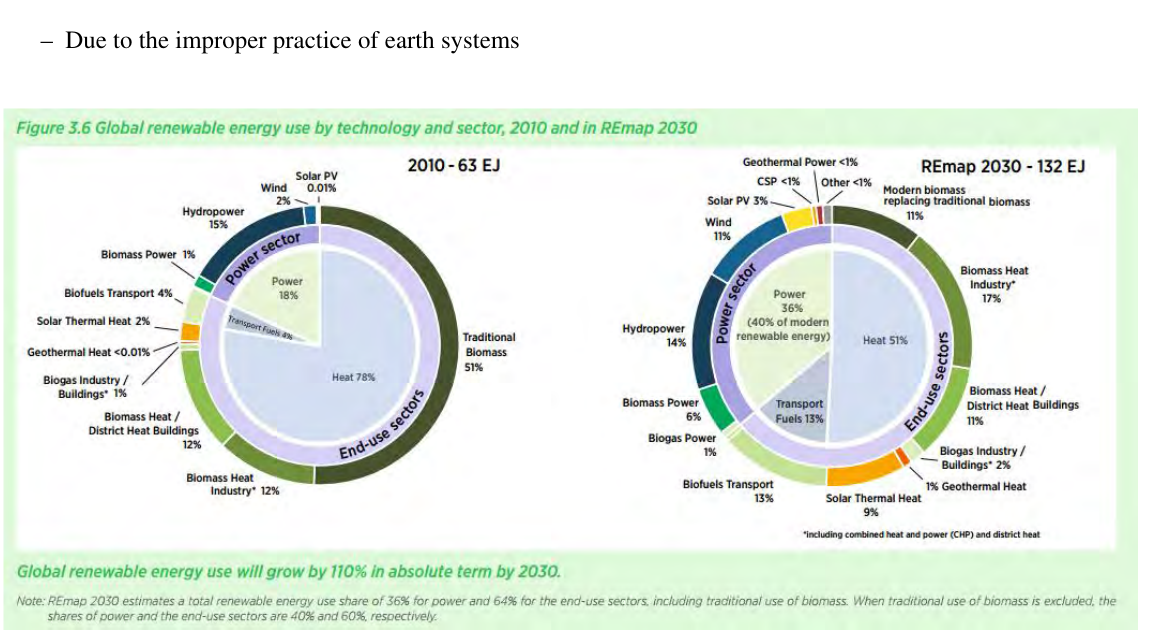
Figure 3. Global renewable energy used by technology & sector, 2010& in Remap 2030